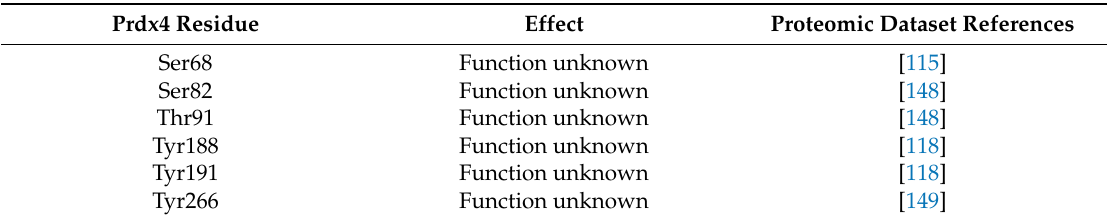
Table 4. Phosphorylation sites that correspond to human Prdx4 in proteomic studies are referenced are indicated.